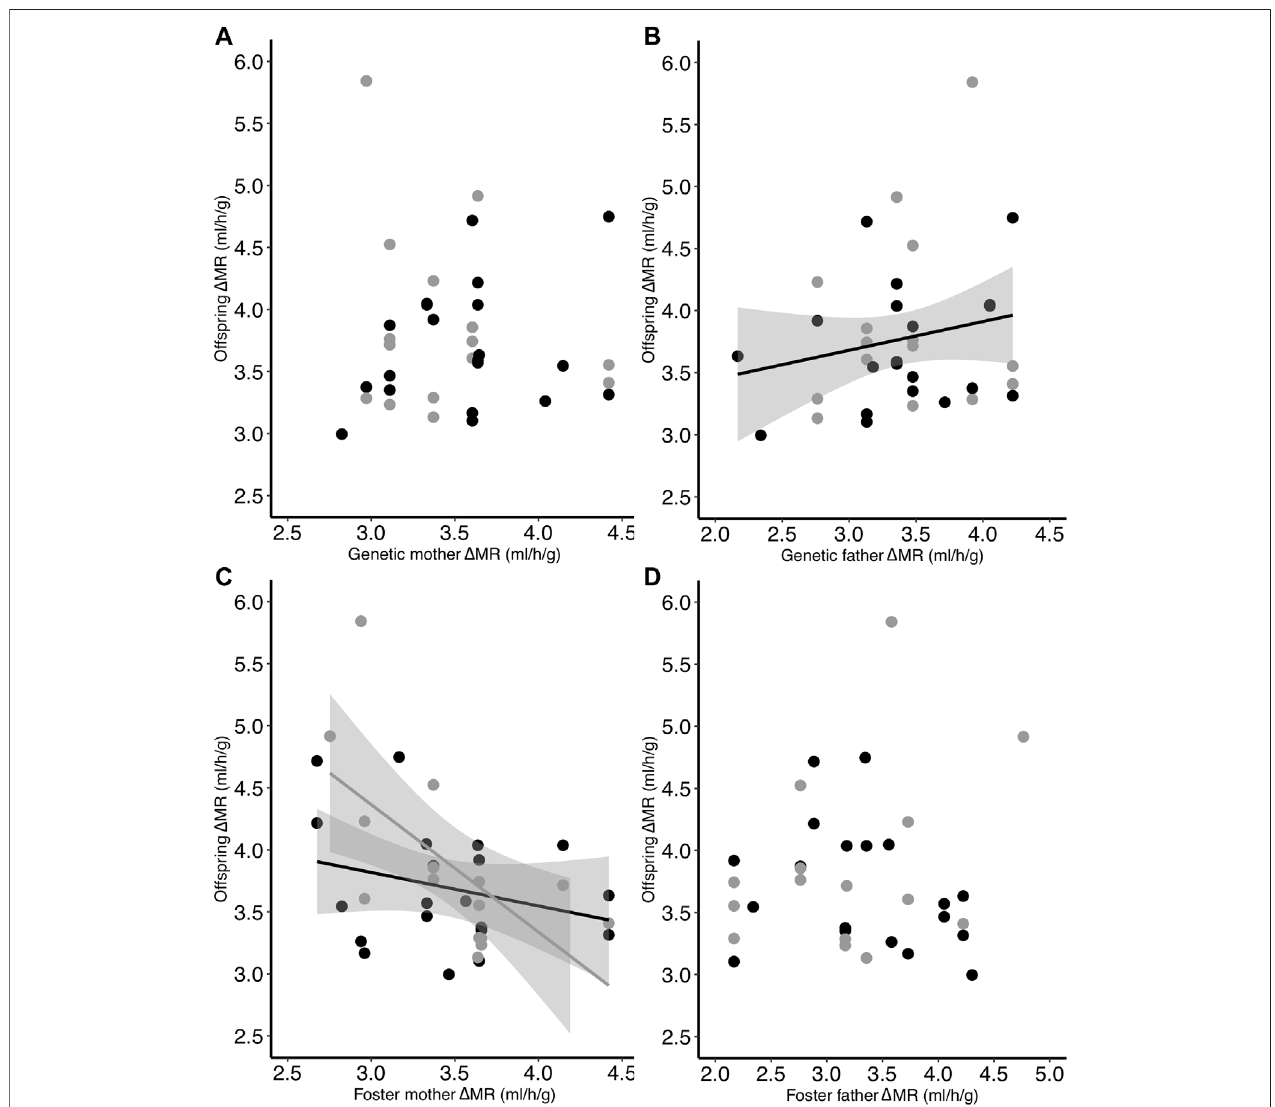
FIGURE 5 | Relationship between the difference in offspring TMR and RMR ( Δ MR) on Day 30 and the Δ MR of the (A) genetic mother, (B) genetic father, (C) foster mother, and (D) foster father. Offspring had been incubated at two different temperatures as eggs (black = control; gray = low). Regression lines are included only for signi fi cant